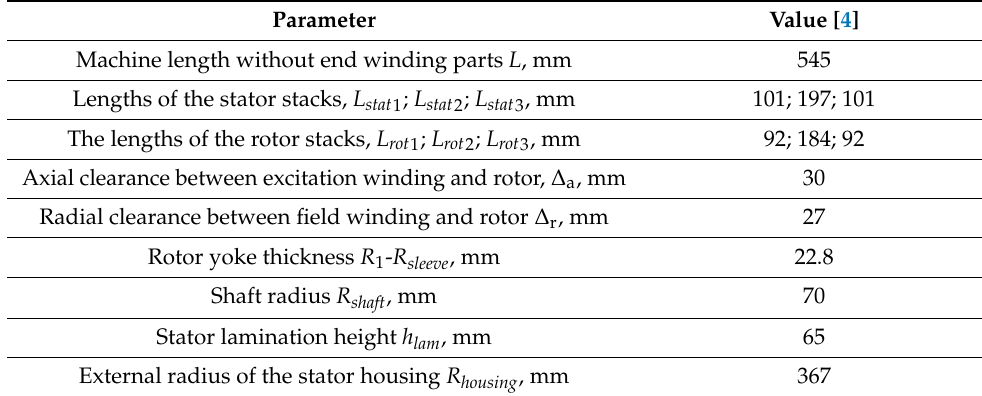
Table 2. Some geometric parameters of the SHM that were not varied during the optimization.